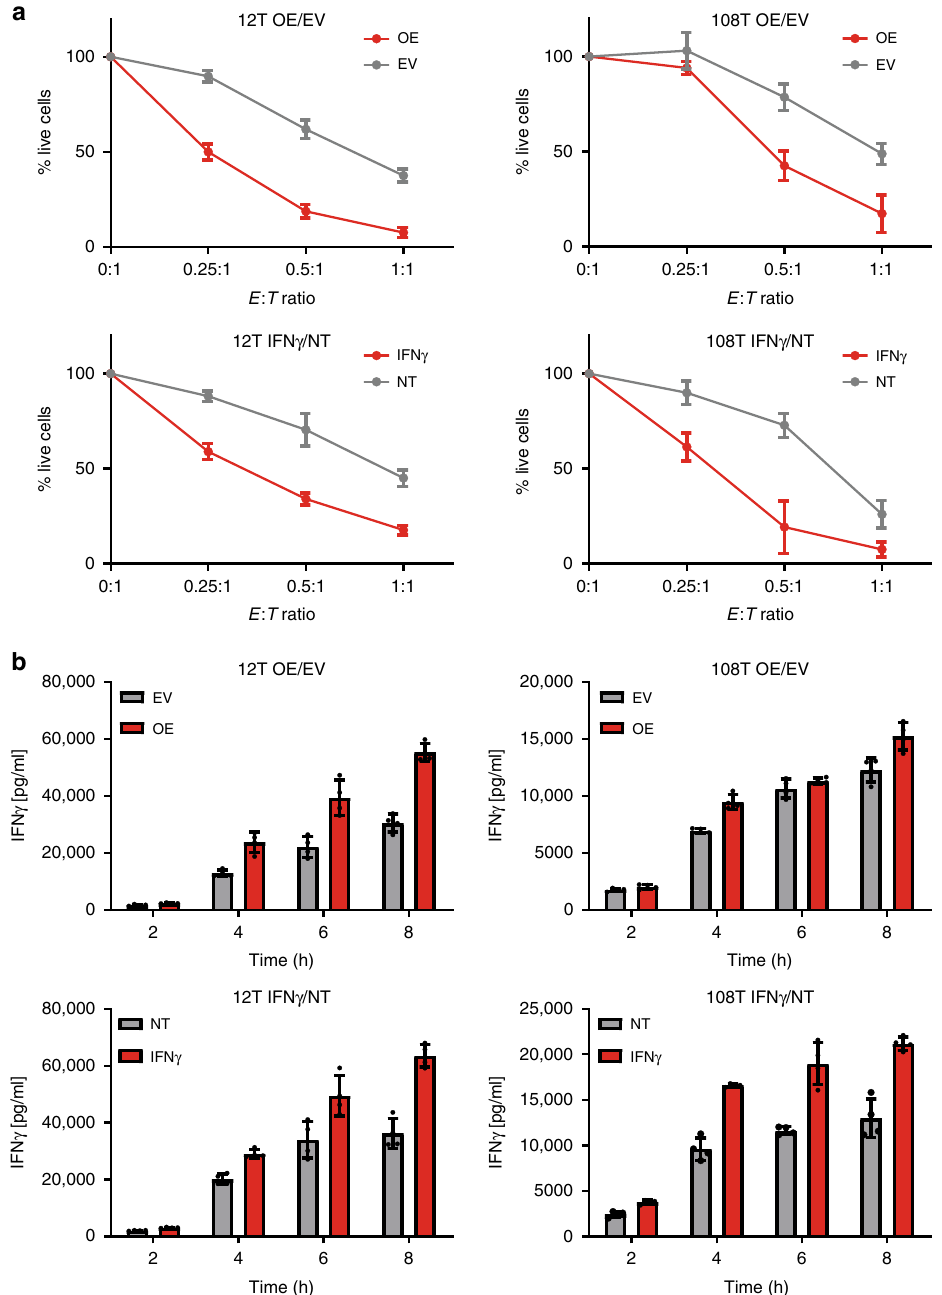
Fig. 2 Reactivity toward cells with overexpression of immunoproteasome subunits is higher compared to control. a Cells with immunoproteasome overexpression compared to empty vector control or cells treated with IFN γ compared to untreated cells were co-cultured in different ratios with autologous TILs. ( E : T , different effector to target ratios). Number of live cells were counted after 8 or 12 h for 12T and 108T, respectively. b IFN γ secretion was measured after 2, 4, 6, and 8 h of co-culture of cells with immunoproteasome overexpression compared to empty vector control or cells treated with IFN γ compared to untreated cells. Data were analyzed from n = 3 biological repeats per each condition and represented as mean ±